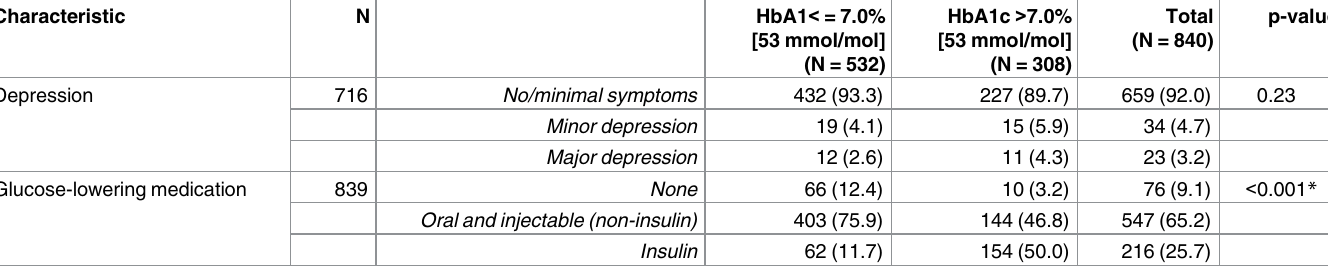
Table 5. Health-related patient characteristics by glycaemic control (categorical variables).